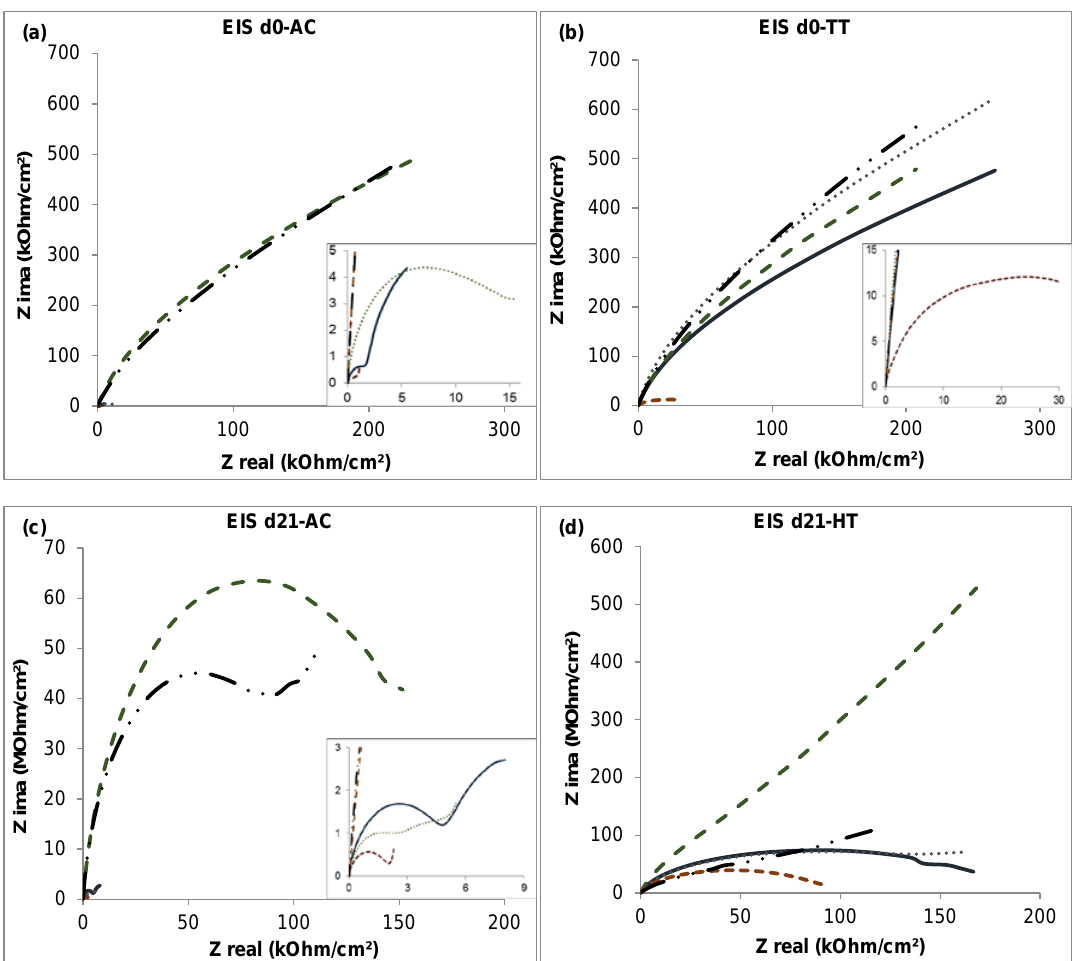
Figure 8. Nyquist diagrams. ( a ) As-cast and ( b ) heat-treated alloys at Day 0 of immersion, and ( c ) as-cast and (d) heat-treated alloys at Day 21 of immersion; (—) 0B, (– –) 0.06B, ( ···· ) 0.25B, (- - - -) 0.5B, and (– · · ) 1B.